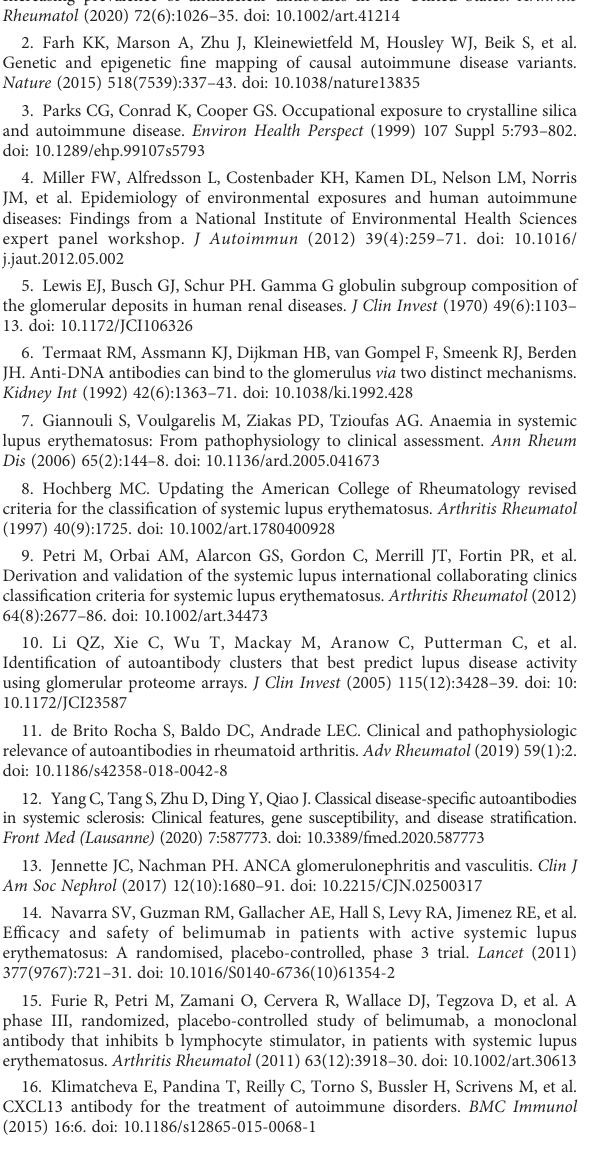
SUPPLEMENTARY FIGURE 1 Lung in fl ammation, lymphocyte in fi ltration, and autoantibodies in bronchoalveolar lavage fl uid (BALF) and serum of female BXSB mice exposed to respiratory crystalline silica or vehicle (saline), with or